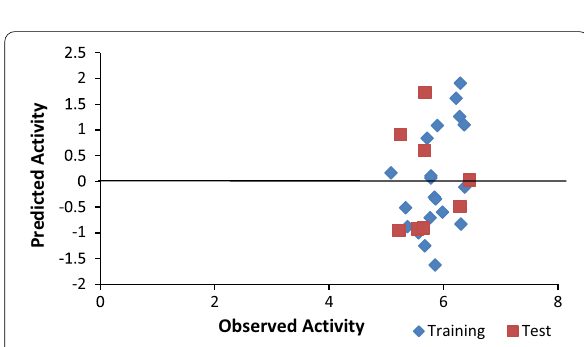
herein for molecular geometry optimization. The